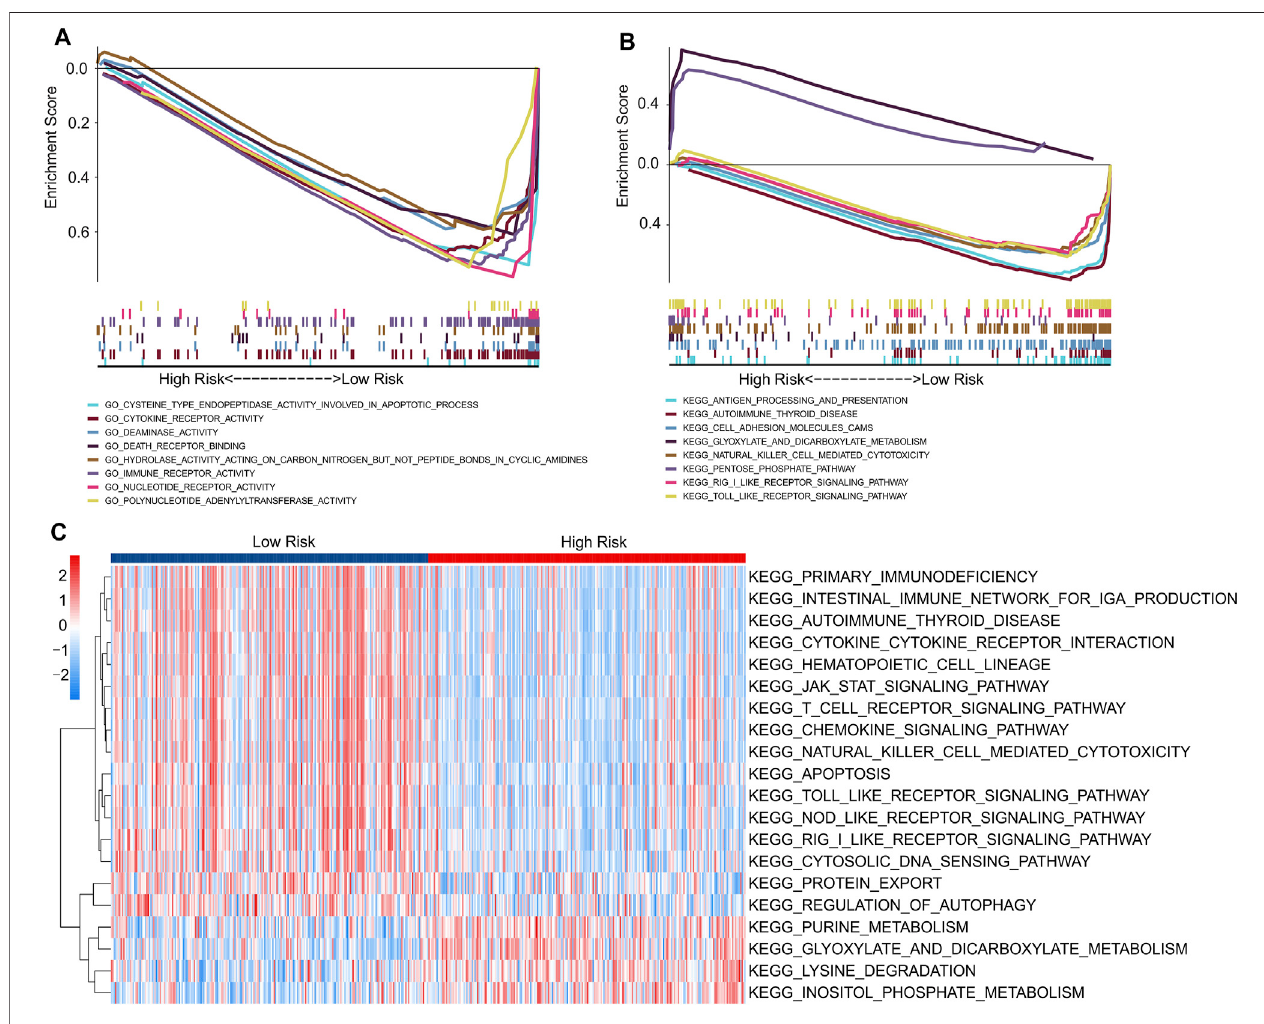
FIGURE 9 | Functional enrichment analysis of low- and high-risk patients with CM. (A) GO analysis shows a signi fi cant enrichment of immune- and apoptotic- related process in low-risk groups. (B) KEGG analysis shows a signi fi cant enrichment of immune-related signaling pathways between low- and high-risk groups. (C) GSVA results indicate the KEGG terms of each patient in low- and high-risk